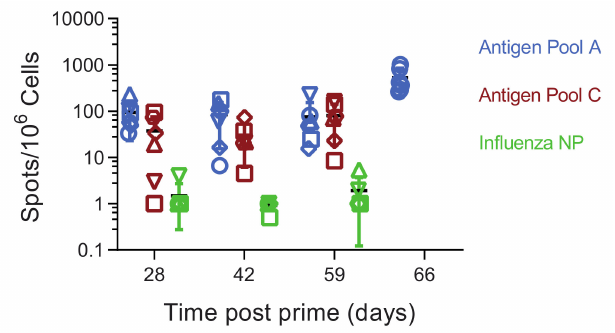
Figure 6. Virus-specific IFN γ responses in animals from experiment 2 immunized with Antigen Pool A (blue), Antigen Pool B (red) or influenza NP (green). The number of ASFV-specific IFN γ producing PBMC were enumerated following in vitro stimulation with ASFV by ELIspot on the indicated days post-prime. Data points indicate the number of spots per million cells induced by the whole virus after background subtraction, error bars indicate standard deviation from the mean. Note that to aid clarity the scale for the virus-specific responses have been set di ff erently to those in Figure